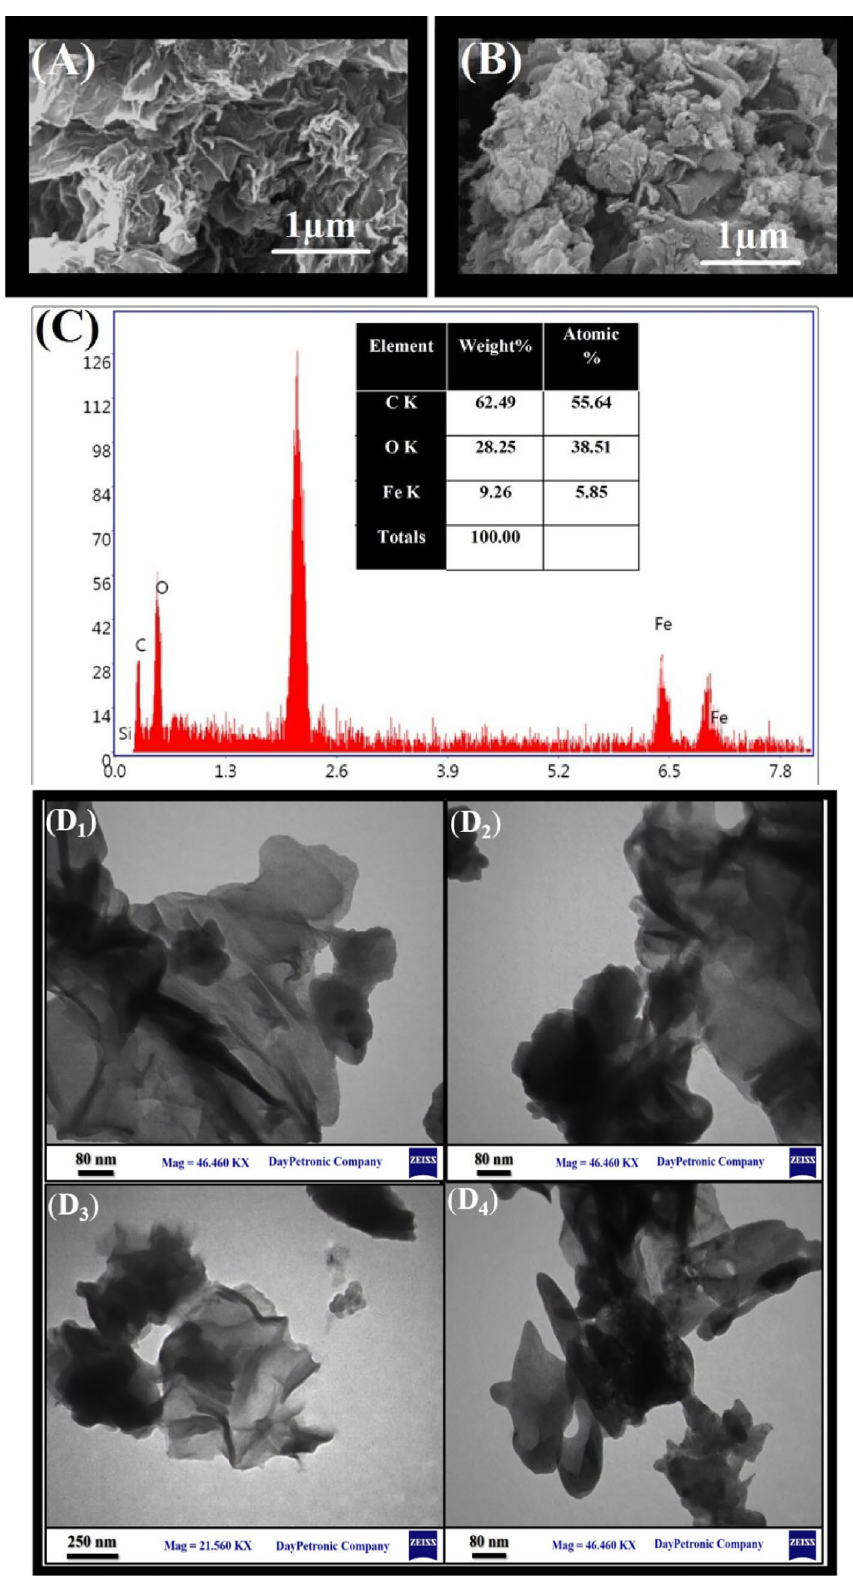
Figure 2. SEM images of graphene oxide ( A ), GO-MIL-100(Fe) ( B ), EDX elemental analysis of GO-MIL- 100(Fe) ( C ), and TEM images of GO-MIL-100(Fe) ( D 1 – D 4